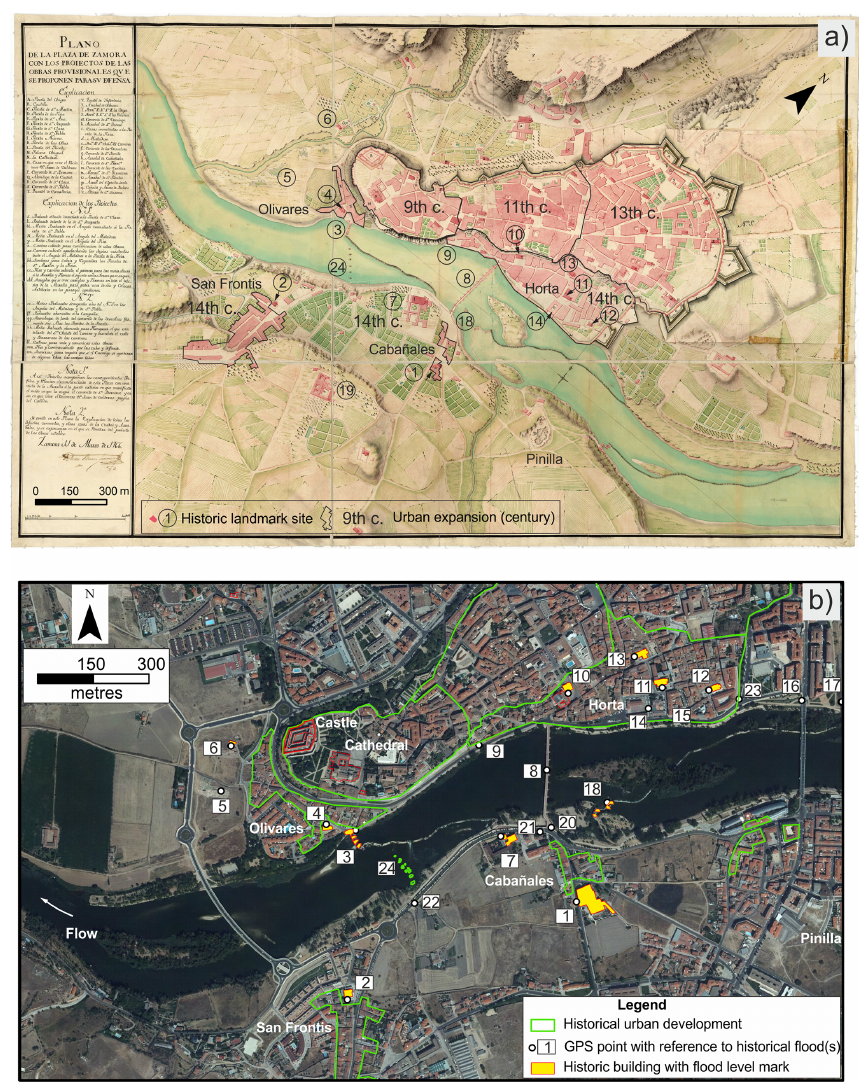
Figure 2. Historic flood landmarks and GPS point locations. (a) Historic map of Zamora (1 : 2900 in scale) published on 11 March 1766 by Juan Martín Cermeño. Old graphic scale of 200 toes (1 toe = 13.5cm). Black polygons illustrate the timing of urban development through time in the old city (9th–13th centuries) and suburbs (14th century and beyond). The city of Zamora was surrounded by walls that in the old city had defence purposes and in the suburbs protected against flooding. (b) Orthophoto of Zamora (year 2017) showing the same urban expansion areas as (a) . Legend: (1) Las Dueñas convent, (2) San Frontis church, (3) Olivares mills, (4) San Claudio de Olivares church, (5) Campo de la Verdad (likely location of old Santa Clara convent), (6) Santiago de los Caballeros church, (7) old